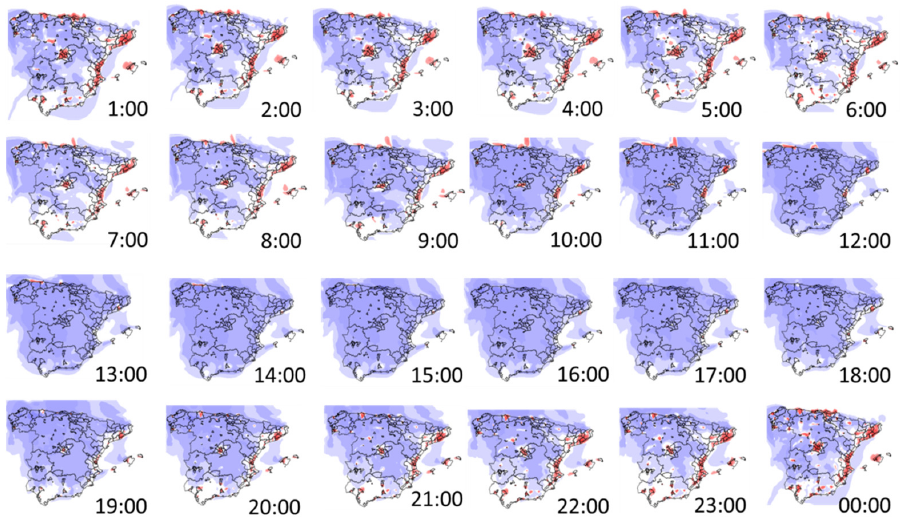
Figure 12. Hourly O 3 concentration difference maps (µg m −3 ) between the WAM2030 scenario and 2016 for one day in summer (18 July 2016). Red colors indicate an increase in ozone for the WAM2030 scenario and blue colors indicate a reduction.